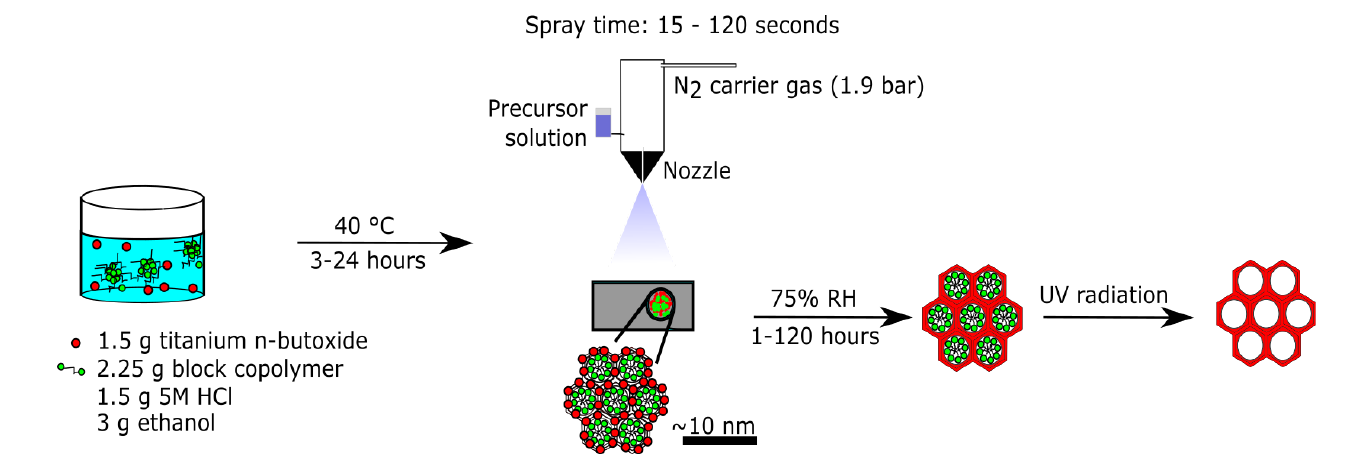
Figure 1. Schematic illustration of the spray deposition synthesis of mesoporous titania films.